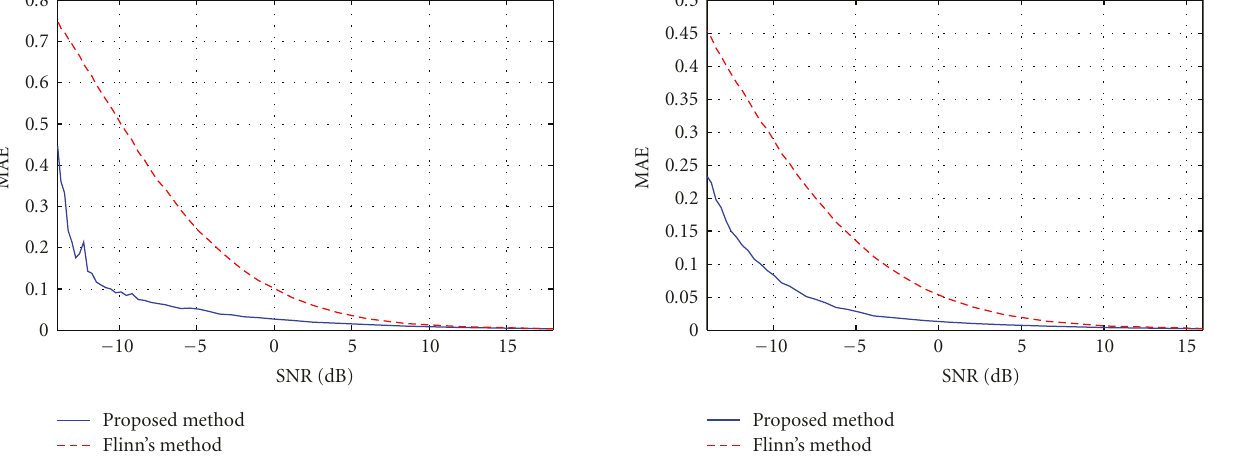
Figure 4: Mean Absolute Error for estimation of the amplitude ratio between components for various SNRs (plain line: MWSM based method; dotted line: Flinn’s